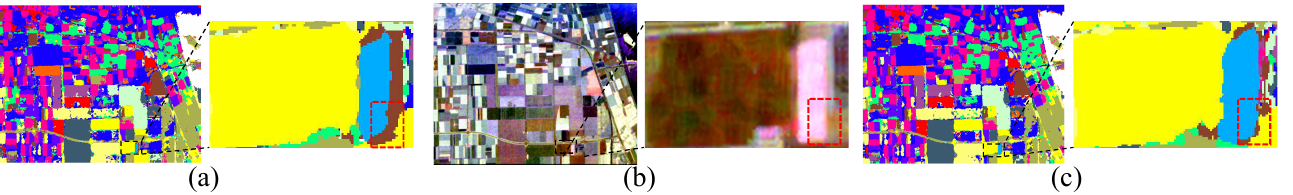
Figure 12. Enlarged results of the Buildings region on AIRSAR Flevoland dataset. ( a ) CapsNet. ( b ) Pauli RGB image. ( c )